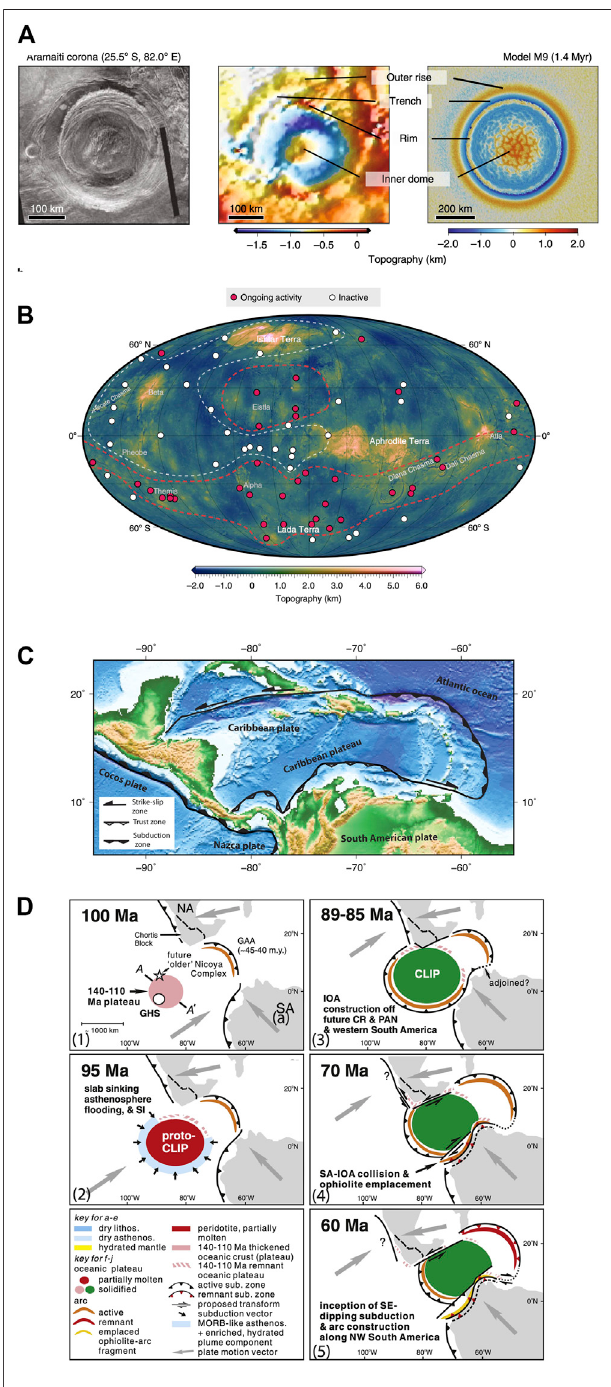
FIGURE 12 | (A) Observation and numerical modeling of Venusian coronae.Atypical coronaeimaged bysynthetic aperture radar(left), observed topography (middle) and simulated topography by numerical modeling (right). (B) Global distribution of coronae classi fi ed as inactive or active. The red andwhitedashedlinecontoursrepresentareasofplumeactivityandinactivity, respectively. Panels in (A,B) are adapted from Gülcher et al. (2020). (C) Present tectonic setting of Caribbean region (adapted from Baes et al., 2020b). (D) Reconstruction of Whattam and Stern (2015). (1) Rising mantle plumebeneath theFarallon plate at 140 Ma formed a small oceanic plateauat ( Continued )